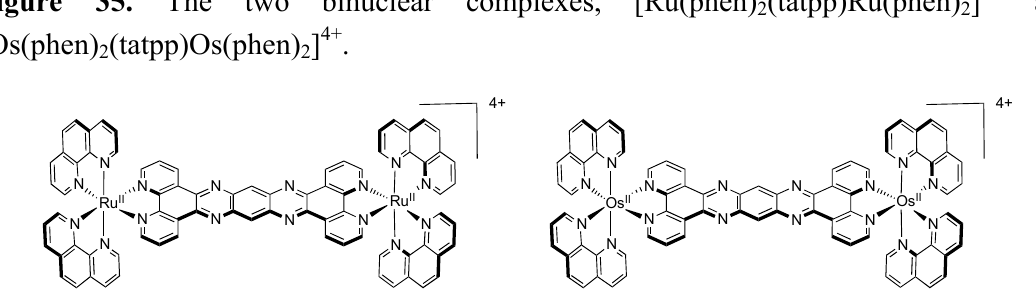
(tatpp)Ru(phen) 2